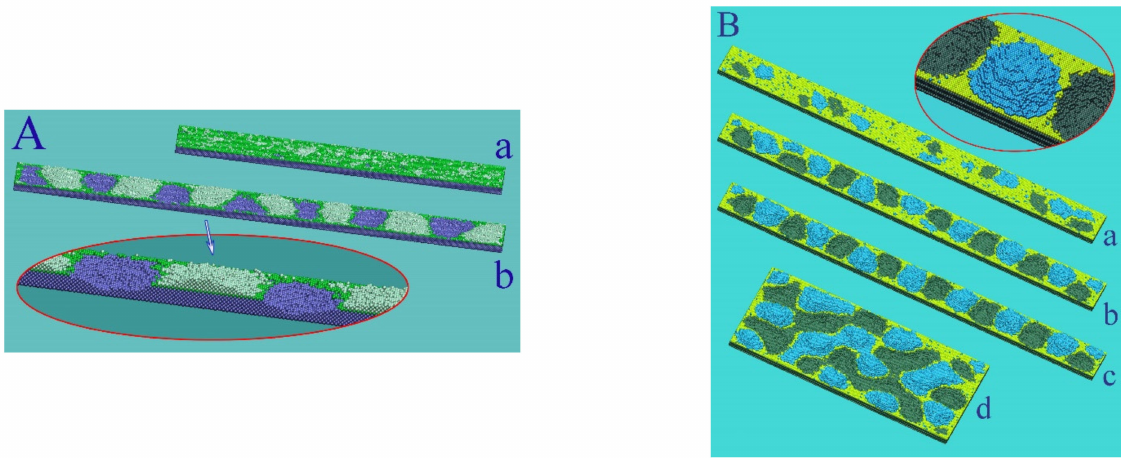
Figure 2. The manifestation of a roughening transition on the upper faces of plates with different orientations. It is assumed that the side faces of the plates, with the exception of the upper face, are in contact with “frozen”/immobile atoms, and the mobile atoms of the plate cannot go beyond the perimeter of the upper face: ( A ) the upper face of the plate is part of the (100) plane. Configuration (a) α = 1, p = 0.7. The plate length is L = 400, width w = 70, height h = 10. In the quasi-steady state, the atomic layer +1 (the top atomic layer in the initial state is marked with the index 0) contains an approximately constant number of atoms around 1600. The formed surface clusters drift along the zero layer, decay, and reappear. (b) − α = 1, p = 0.825. L = 600, w = 70, h = 10. t = 2.9 × 10 6 MC steps. The number of broken bonds in the system of mobile atoms, N bb ( t ) , reaches saturation at τ sat ≈ 2.5 × 10 6 MC steps. The bottom inset shows the surface structure of the plate in the longitudinal middle section; ( B ) dynamics of a plate with an upper face (111) type. (a–c) L = 700, w = 70, h = 10. (cid:0) × (cid:1) ≈ α = 1, p = 0.825. t = 0.5, 1.0, 1.5 τ sat . Configuration (d) L = 370, w = 200. t = 1.4 × 10 6 10 6